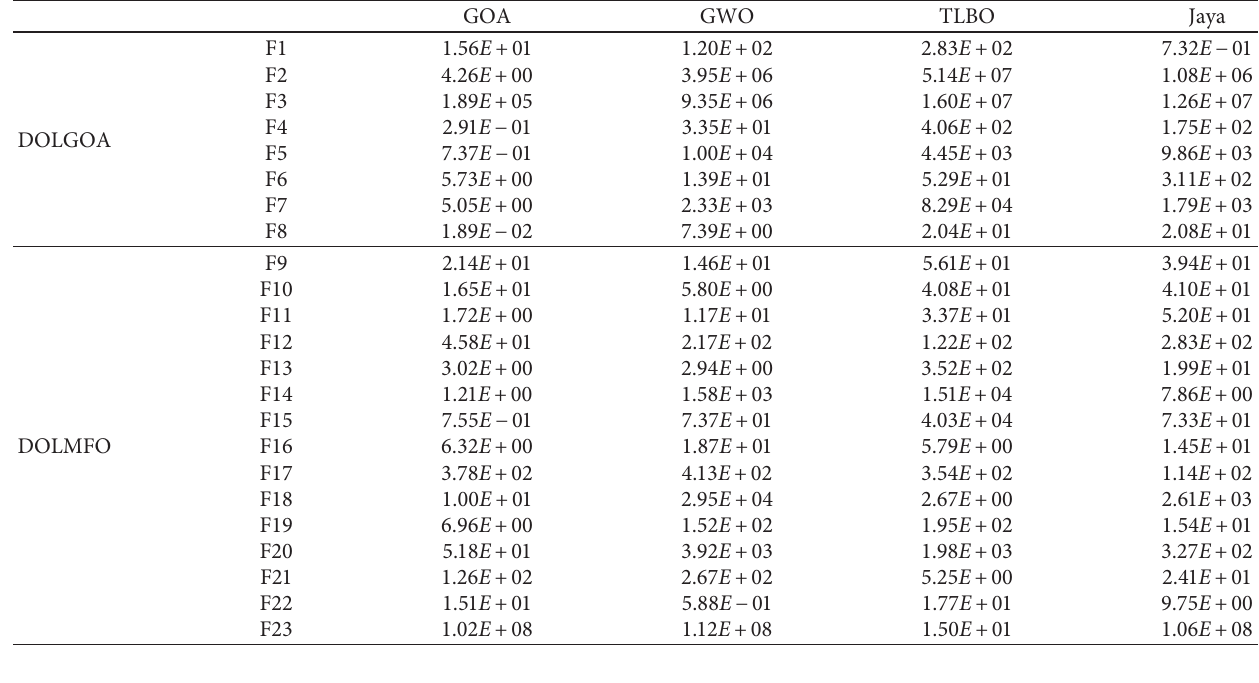
Table 6: The t values of DOLGOA and other algorithms.